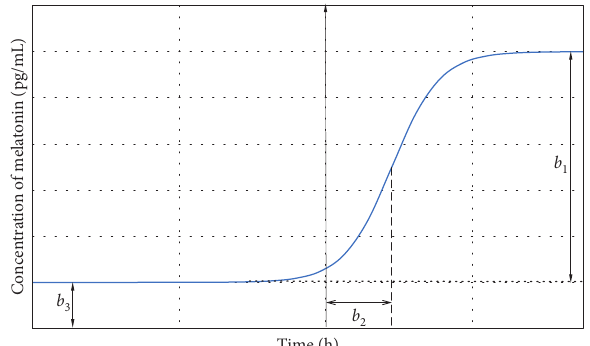
Figure 1: The melatonin secretion model. The solid line shows the curve-shaped function approximating the melatonin secretion with the following parameters: b 1 is the melatonin release amplitude; b 2 is DLMO 50E ; b 3 is the minimum melatonin concentration; and dotted line is the minimum melatonin concentration